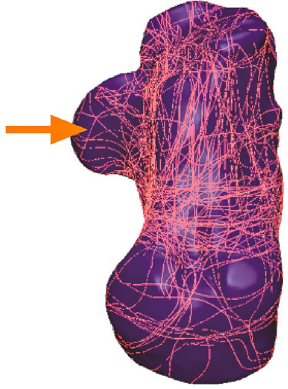
Figure 4. The method used for 3D CT mapping of sustentacular fracture. Representative views of the 3D map of the 81 calcaneal fracture